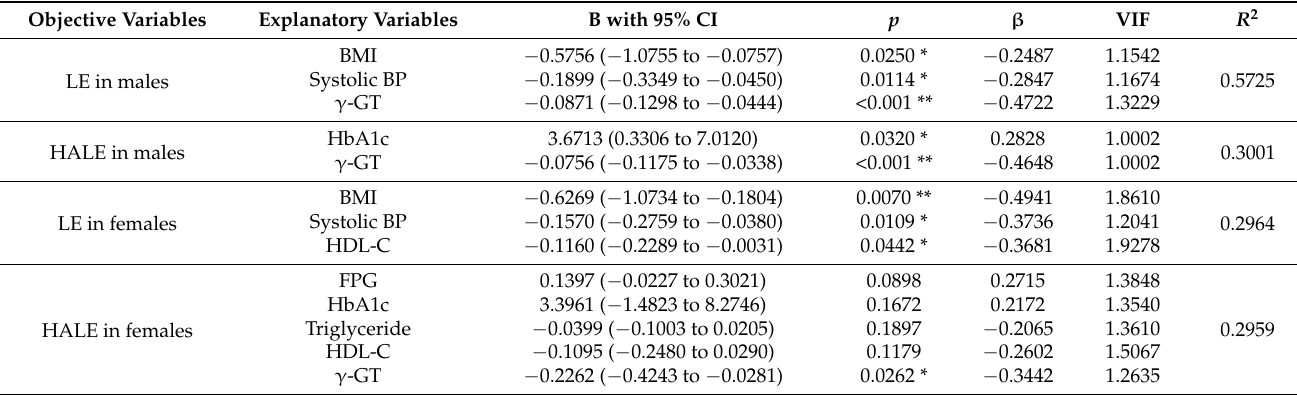
Table 5. Multiple regression analysis between population health outcomes and laboratory tests as explanatory variables.